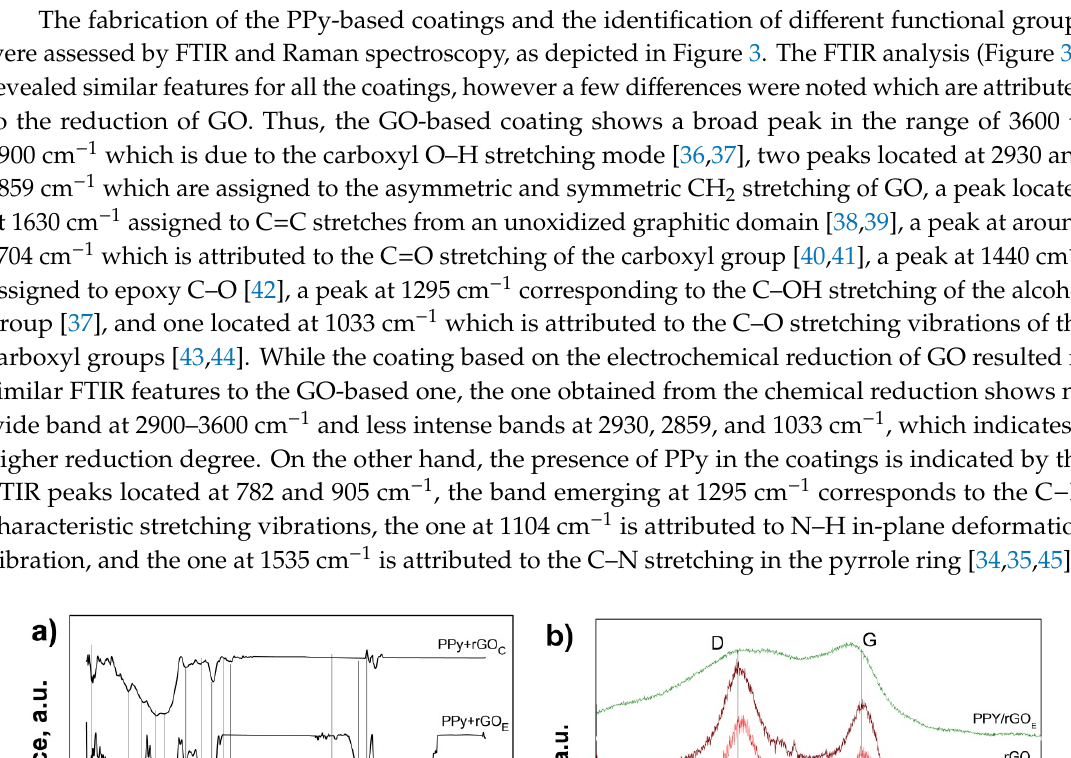
Figure 2. Cyclic voltammetry of polypyrrole (PPy) at the surface of ceramic substrates (CS) before ( a ) and after modification with graphene oxide (GO)-based films ( b ); evolution of the PPy deposition charge with the coating on the CS substrates ( c ).